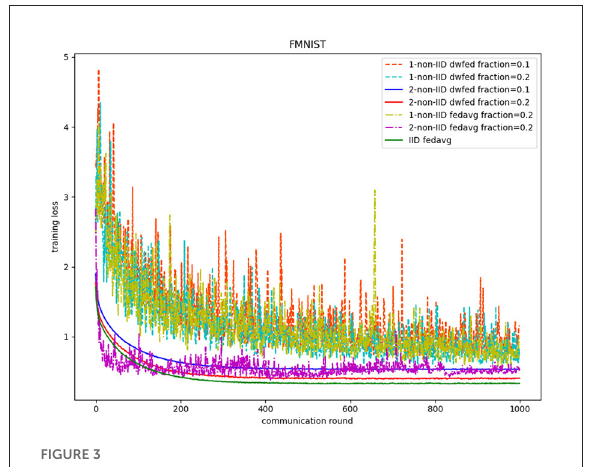
FIGURE3 Training loss on fashion MNIST.